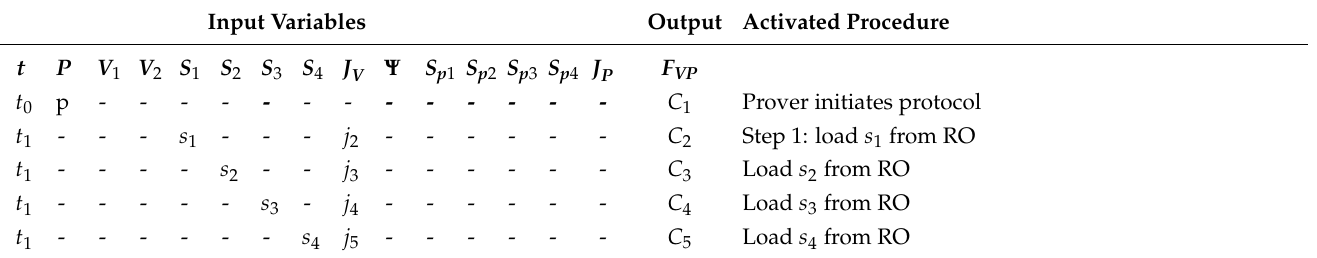
Table 5. Truth table of the F VP function, modelling interaction of the prover and the verifier agents in the route verification scheme [79]. Procedure describes execution of protocol PU and involves RO. Logic function can be written as a set of product terms and used as entry in the logic